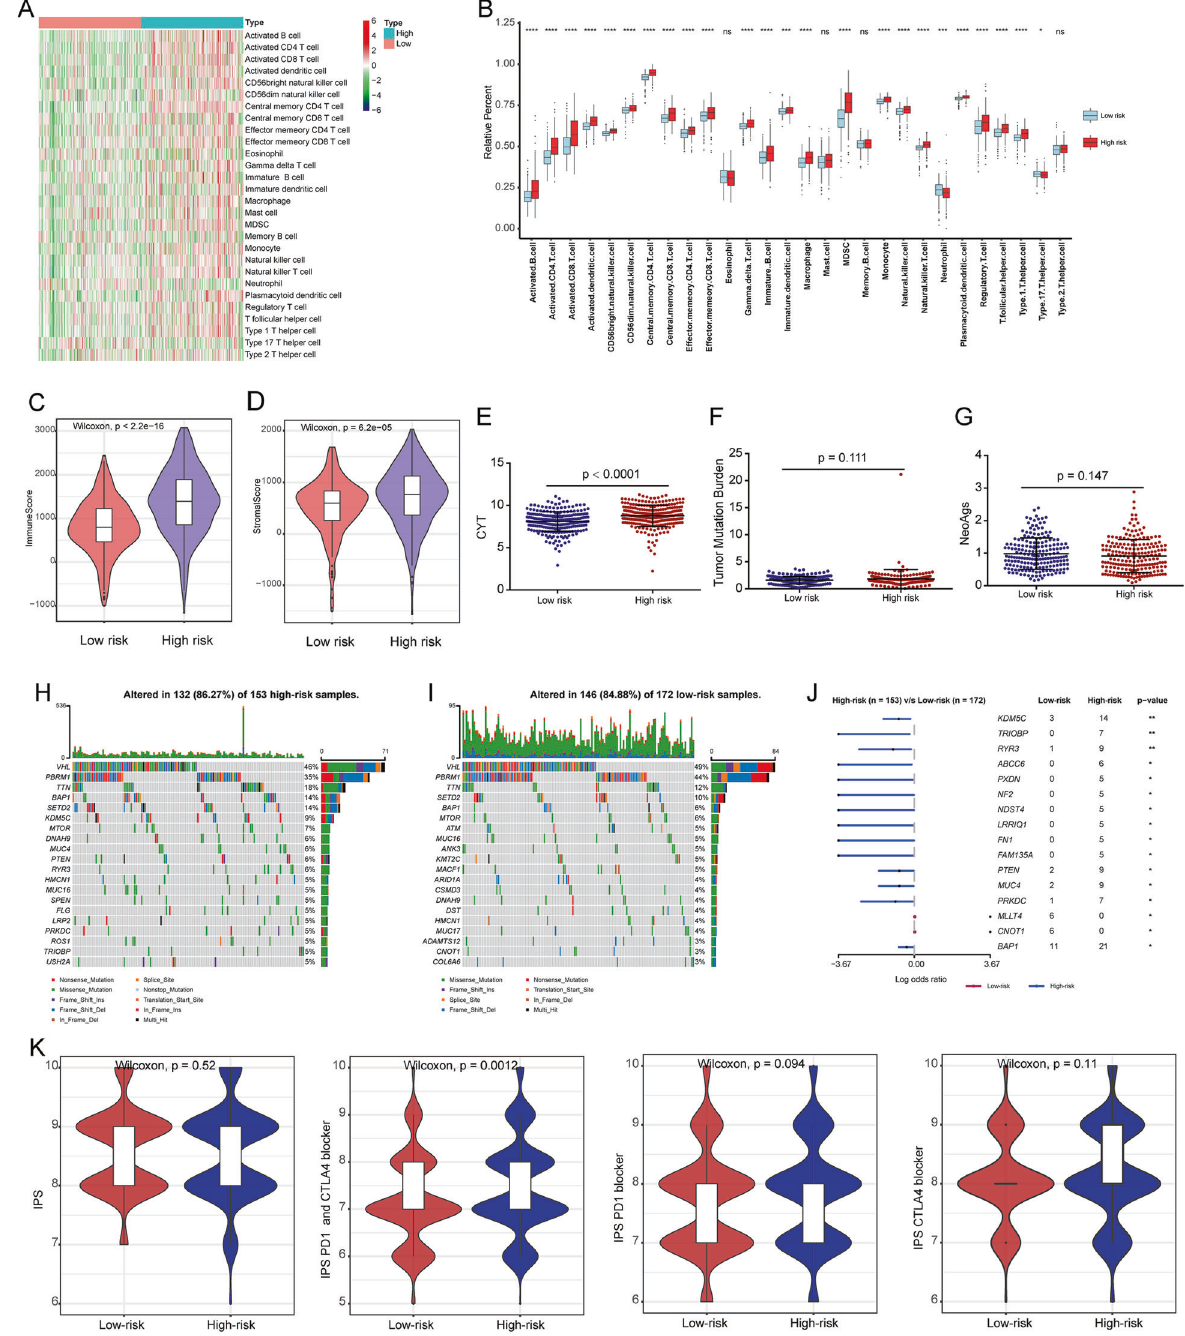
Fig. 7 Evaluation of tumor immune microenvironment and genomic alterations. A The distributions of 28 immune cells in high-risk and low-risk patients. B Box plots showed the detailed differences for 28 immune cells between high-risk and low-risk patients. The differences of the immune score ( C ), stromal score ( D ), cytolytic activity score ( E ), tumor mutation burden ( F ), and neoAgs ( G ) in high-risk and low-risk patients. The mutation pro fi le of the top 20 mutation genes in high-risk patients ( H ) and low-risk patients ( I ). The Forest plot illustrated the differences in mutation frequency of genes in high- and low-risk patients ( J ). Comparison of the IPS, IPS-PD1 blocker, IPS-CTLA4 blocker, and IPS-CTLA4 and PD1 blocker between high-risk and low-risk patients ( K ). * P < 0.05, ** P < 0.01, *** P < 0.001, **** P <